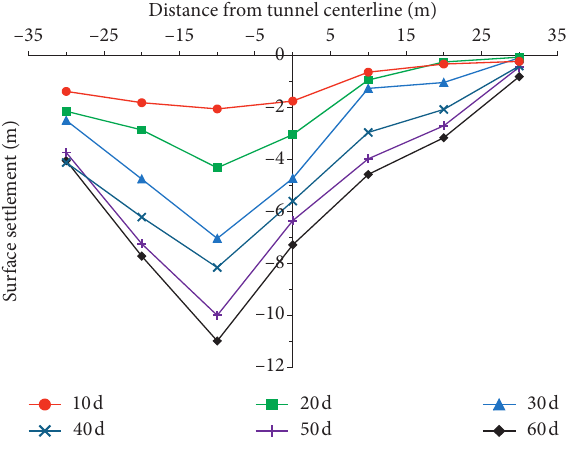
Figure 20: Shaft-to-cross passage measurement point varies with monitoring days.